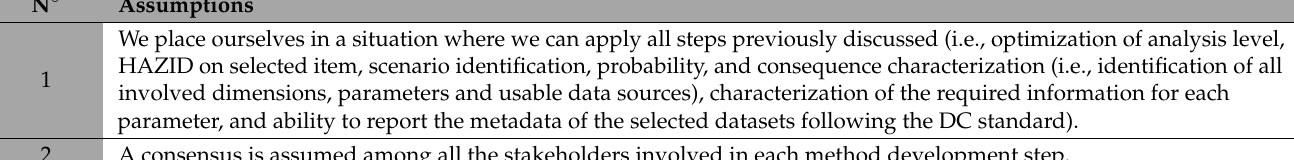
Table 1. List of assumptions made for the development of the presented method.